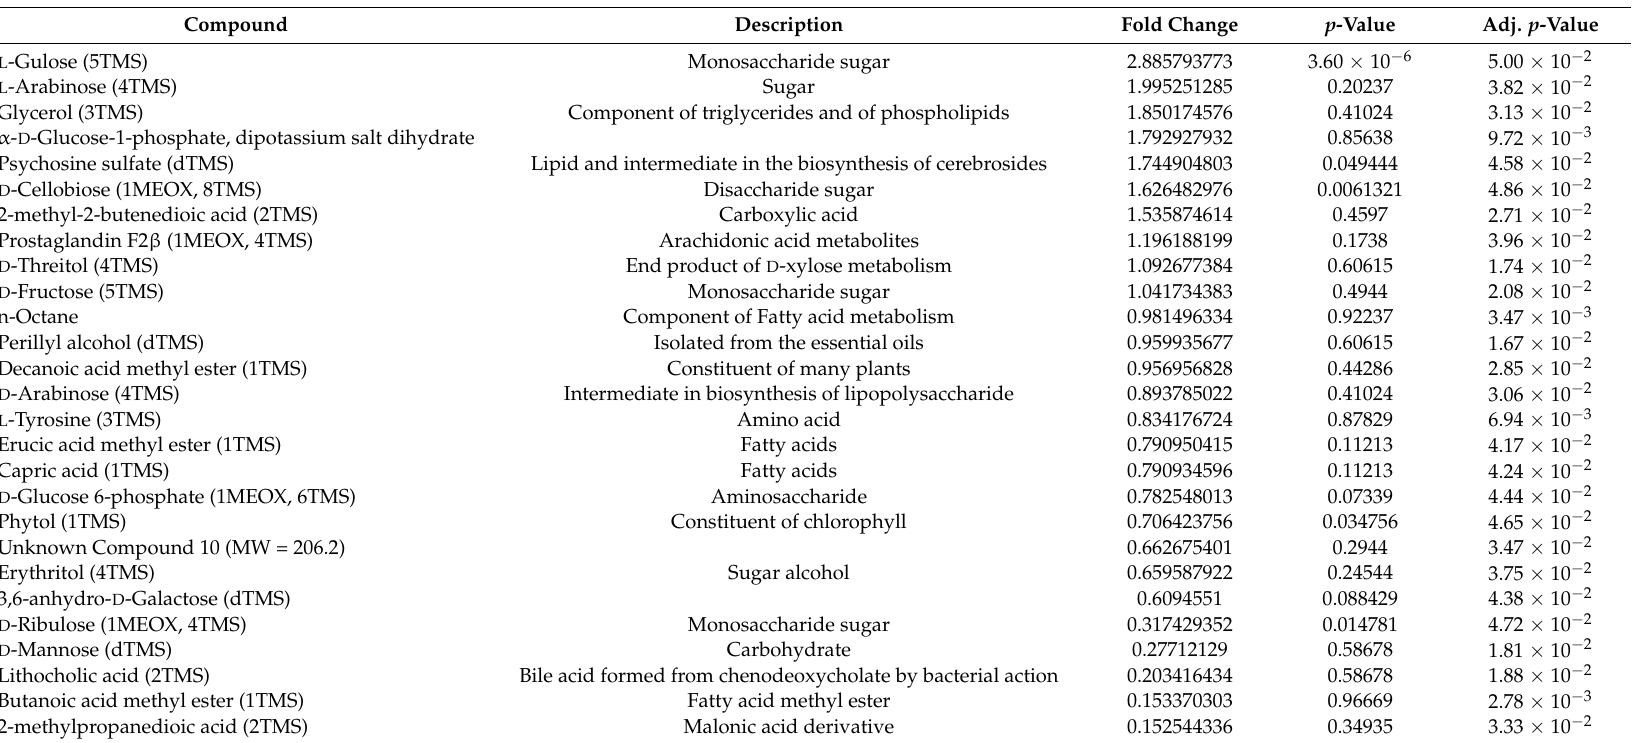
Table 6. Most significant metabolites from the sampled river sites identified by based on their fold change (FC), p -value and Adjusted (Adj.) p -values.